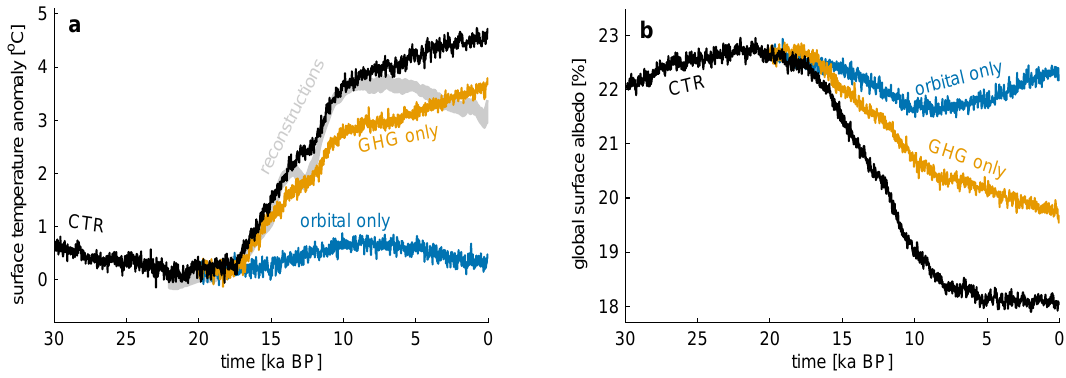
Figure 5. Evolution of global mean annual mean surface temperature anomaly relative to 21kaBP (a) , and surface albedo (b) for the control run with both orbital and GHG forcing (black, CTR), only GHG forcing (orange, fixed 21kaBP orbit), and only orbital forcing (blue, fixed 21kaBP GHGs). Gray shading in panel (a) shows global mean surface temperature anomaly reconstructions (Shakun et al., 2012; Marcott et al., 2013).